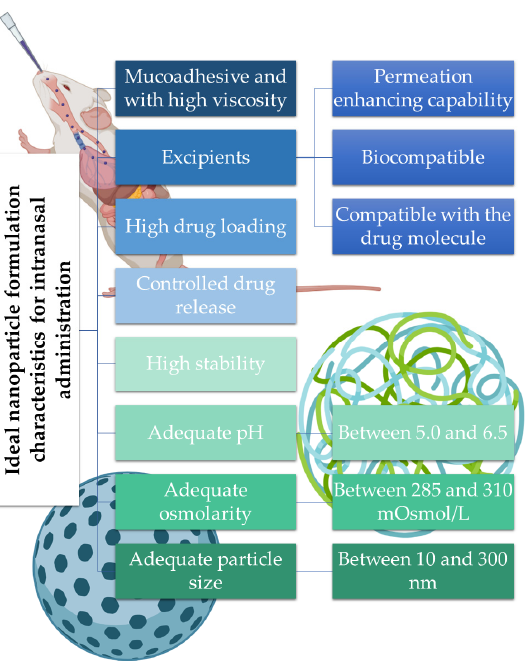
Figure 3. Summary of the ideal nanoparticle formulation characteristics for intranasal administration.